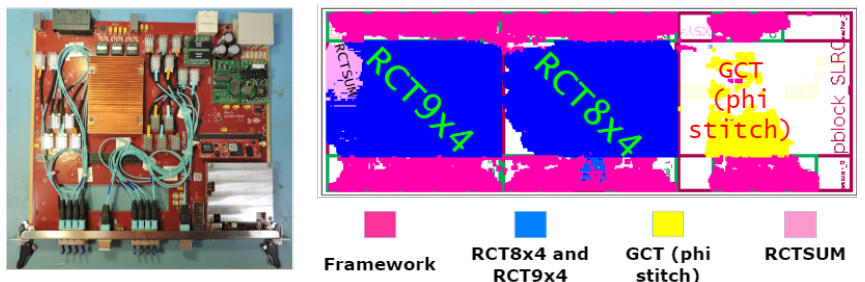
Figure 8. ( Left ): prototype APd1 board hosting the Xilinx XCVU9P C2104 package FPGA. ( Right ): Floor-planning and placement of the RCT and GCT algorithm on XCVU9P